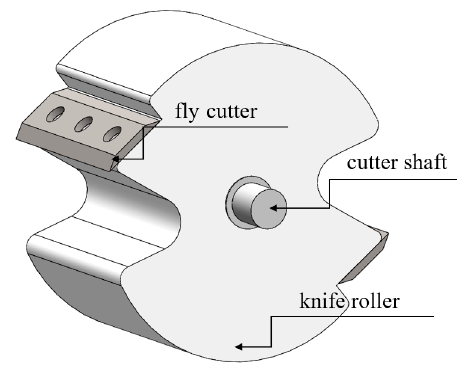
Figure 6. Knife roller structural Figure 6. knife roller structural representation. Figure 6. knife roller structural representation.